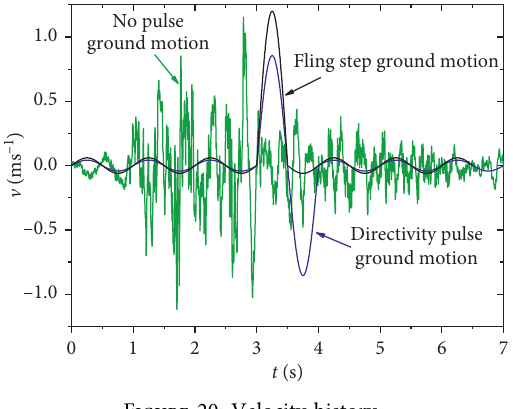
Figure 20: Velocity